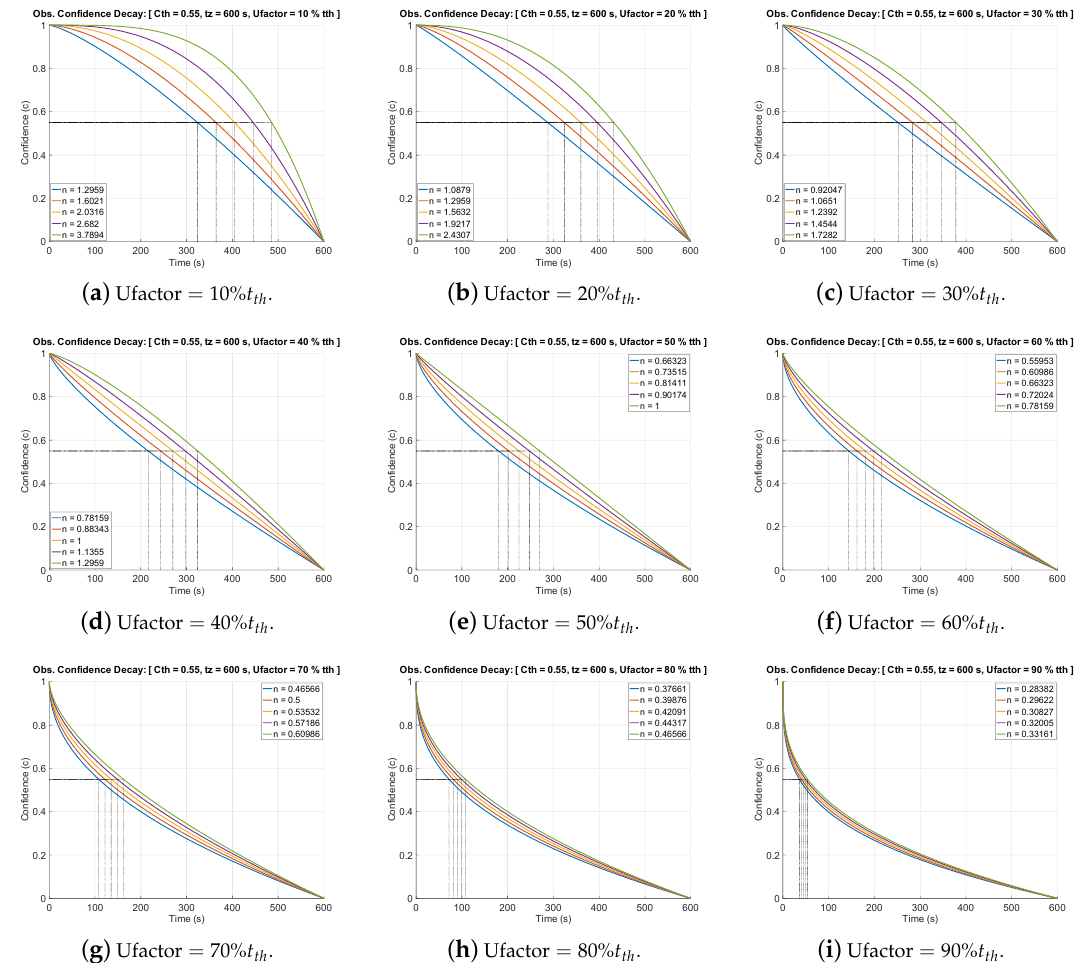
Figure 8. Obstacle confidence decay function with uncertainty integration. With more positional uncertainty, the confidence falls below the threshold confidence fast. In all the cases, c th = 0.55 and t z = 600